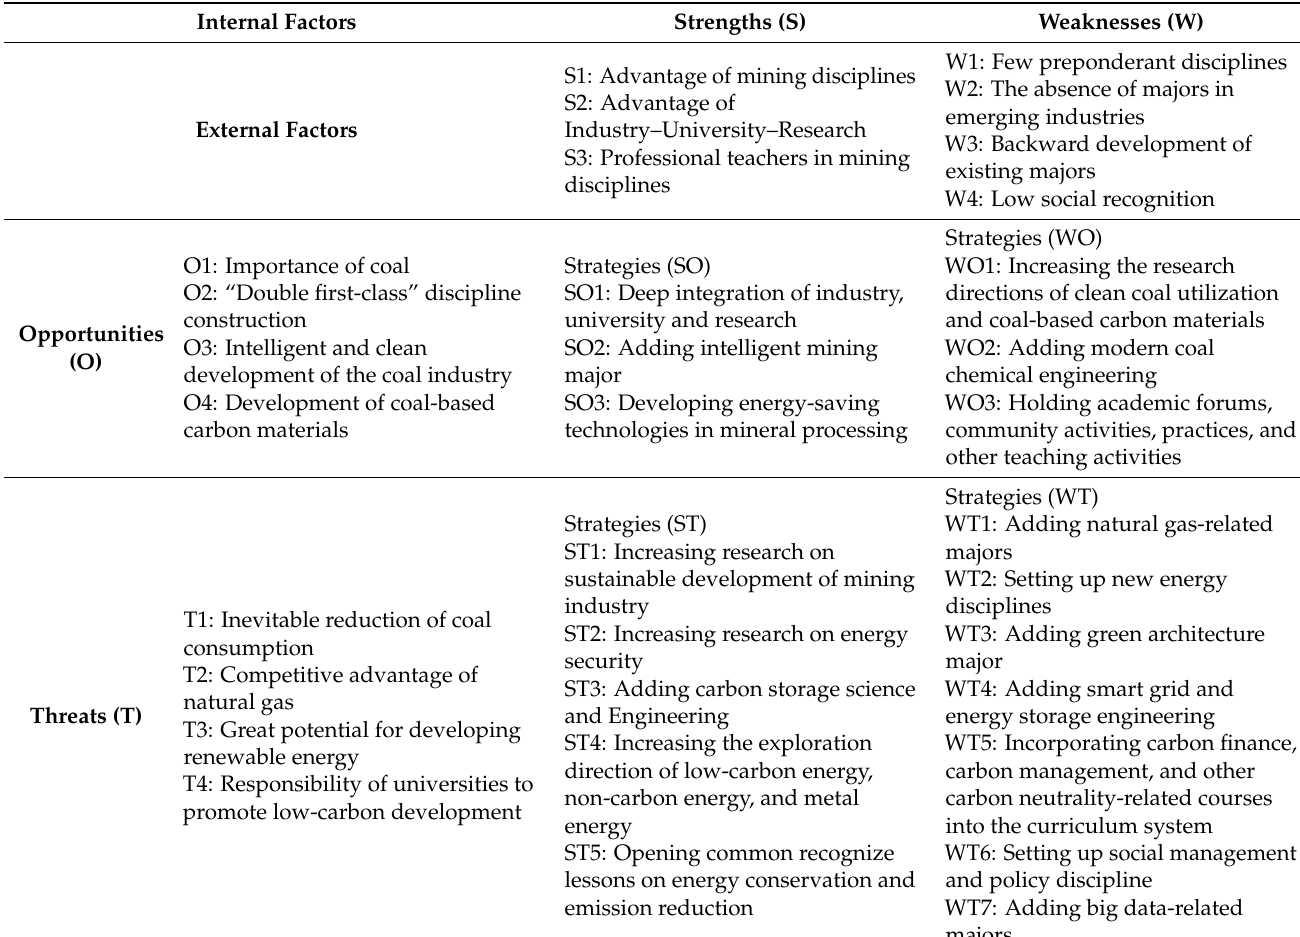
Table 2. SWOT matrix of specialty structure optimization of the universities featuring